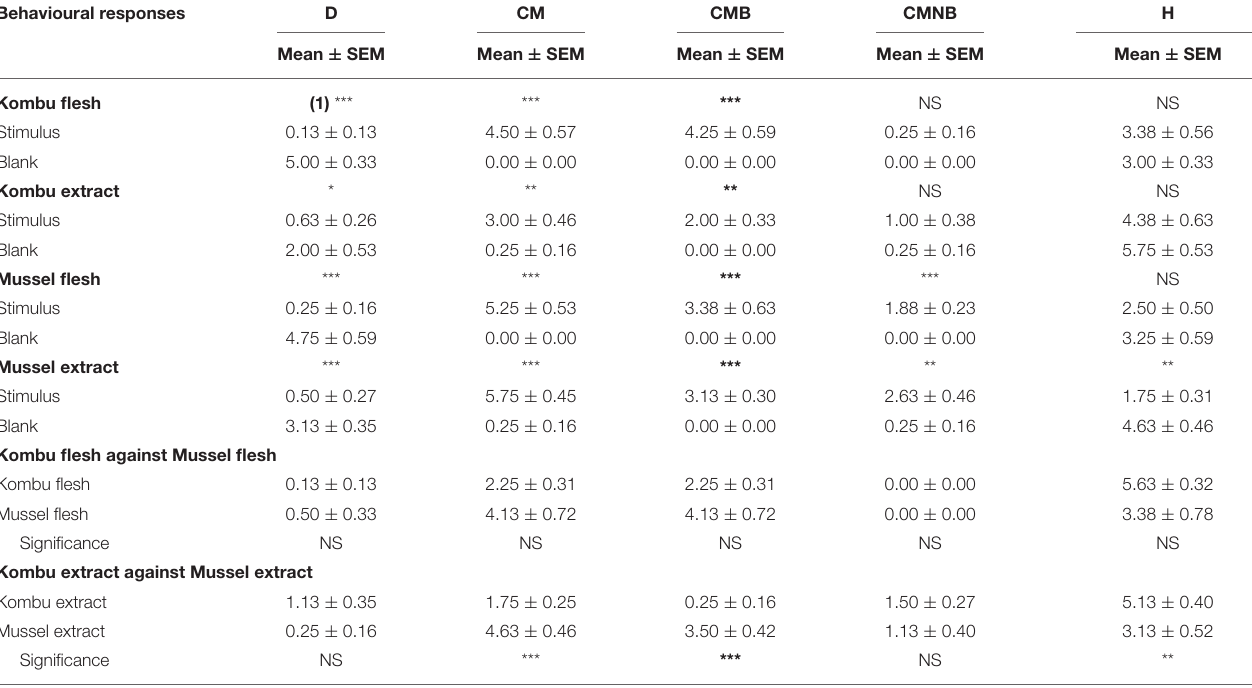
TABLE 7 | Plant eater or meat eater. Behavioural